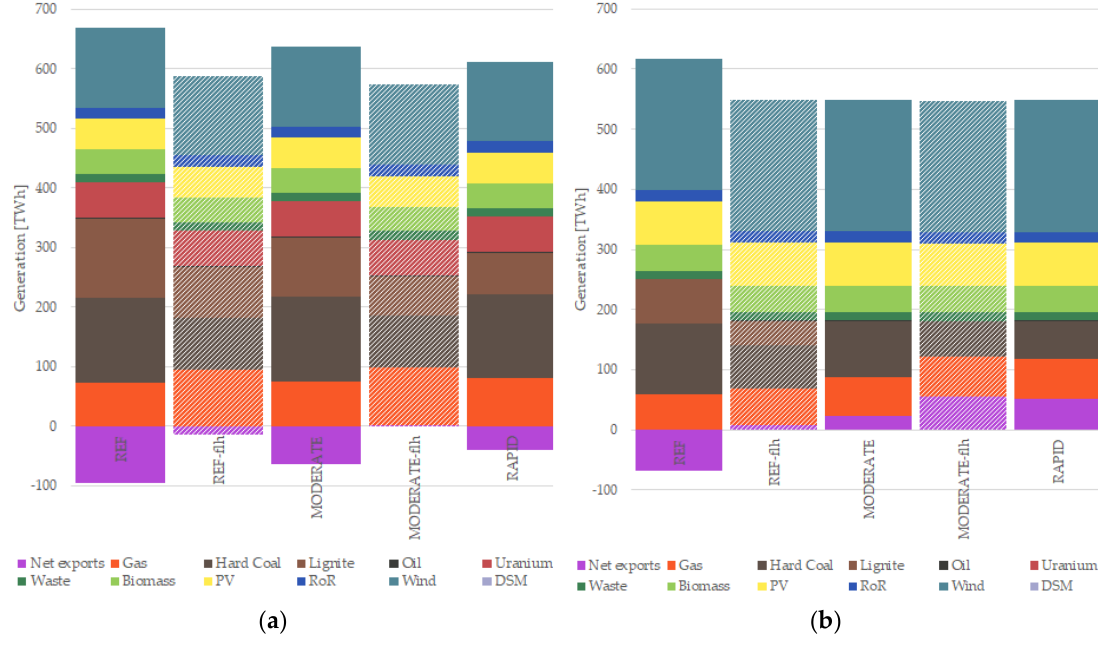
Figure 2. Electricity generation and trade in Germany in 2020 ( a ) and 2030 ( b ). Net imports are denoted positively, net exports negatively (own